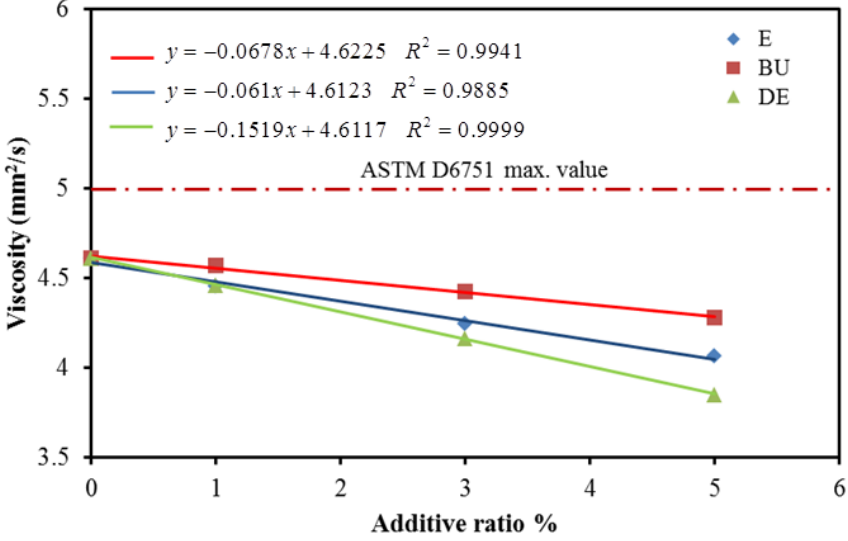
Figure 4. Variation in palm oil methyl ester kinematic viscosity with increasing blending ratio for different chemical